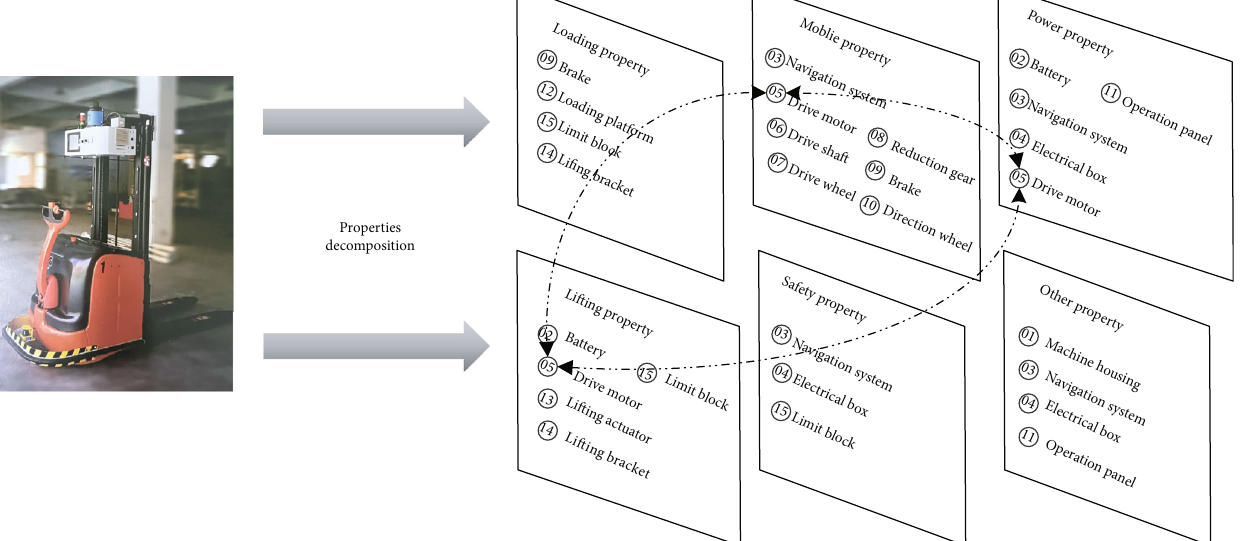
Figure 7: AGV property decomposition.